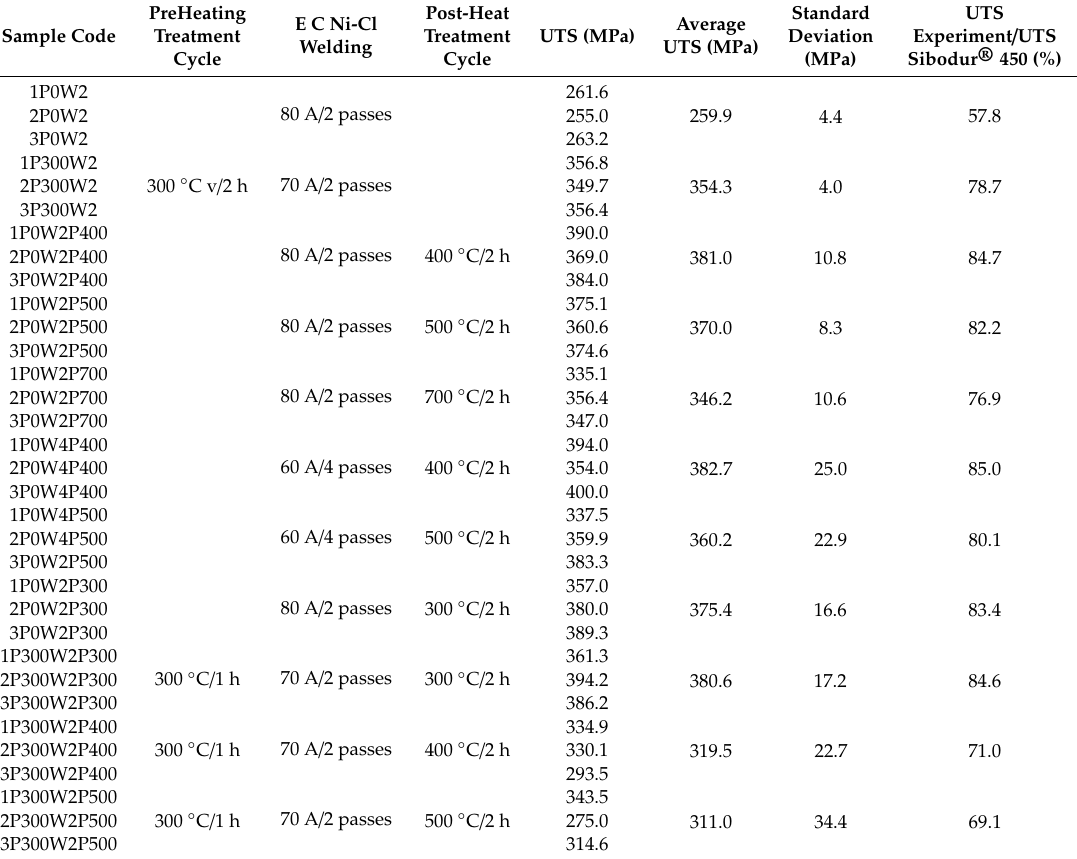
Table 2. Di ff erences between the welding procedures and heat cycles parameters and tensile test obtained